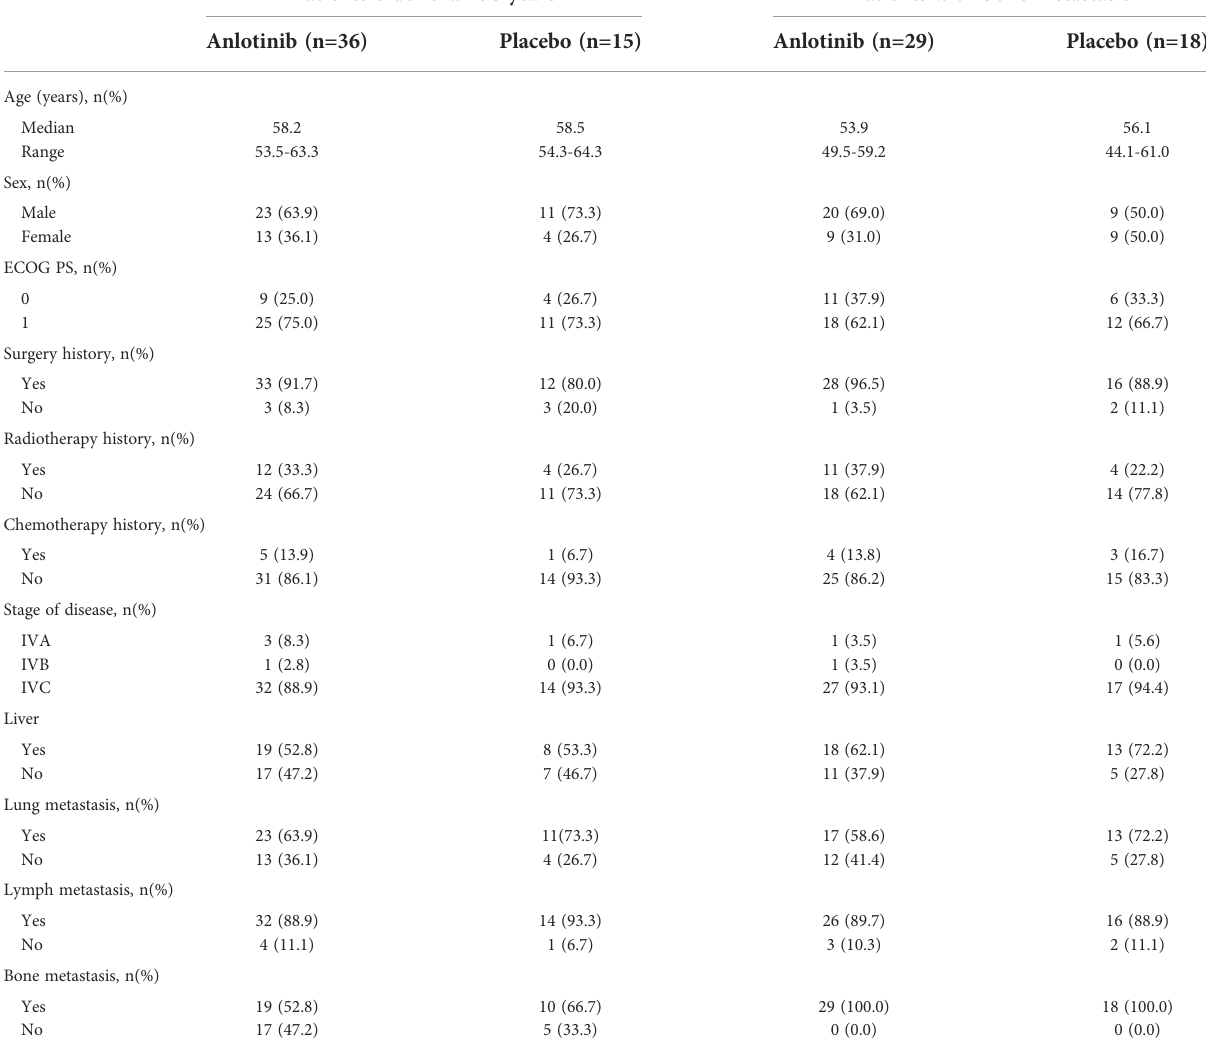
TABLE 1 Baseline characteristics of patients in the different